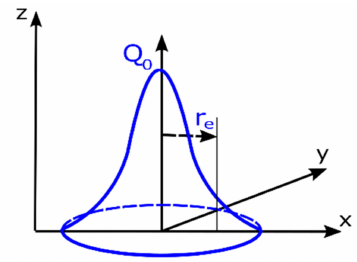
Figure 1. Gaussian surface heat source model